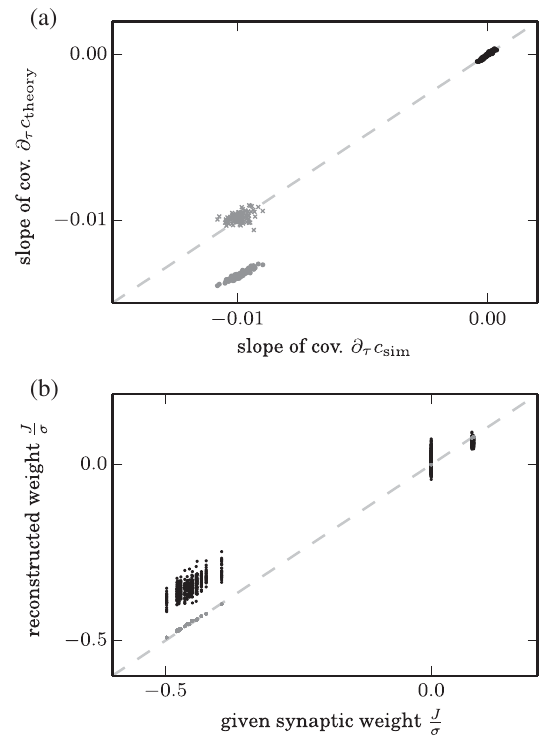
FIG. 8. Reconstruction of couplings from the matrix of co- variances and slopes of the covariance functions at zero time lag. (a) Slope of autocovariance (gray) and cross-covariance functions (black) at zero time lag from the Gaussian approximation versus slope taken from simulation results. Dots show the prediction of the linear theory (36), and crosses the approximation − 1 m 1 − m k ð k Þ for the slope of autocovariances. (b) Recon- 2 structed synaptic amplitude w kl in a network of Ornstein- Uhlenbeck processes (37) (gray) and reconstructed weights J = σ kl k (40) (black) in a binary network versus original couplings used in simulation. Covariance and slope averaged over 20 repetitions, each simulated for T ¼ 2 ; 000 ; 000 ms. Other net- work parameters are the same as in Fig.